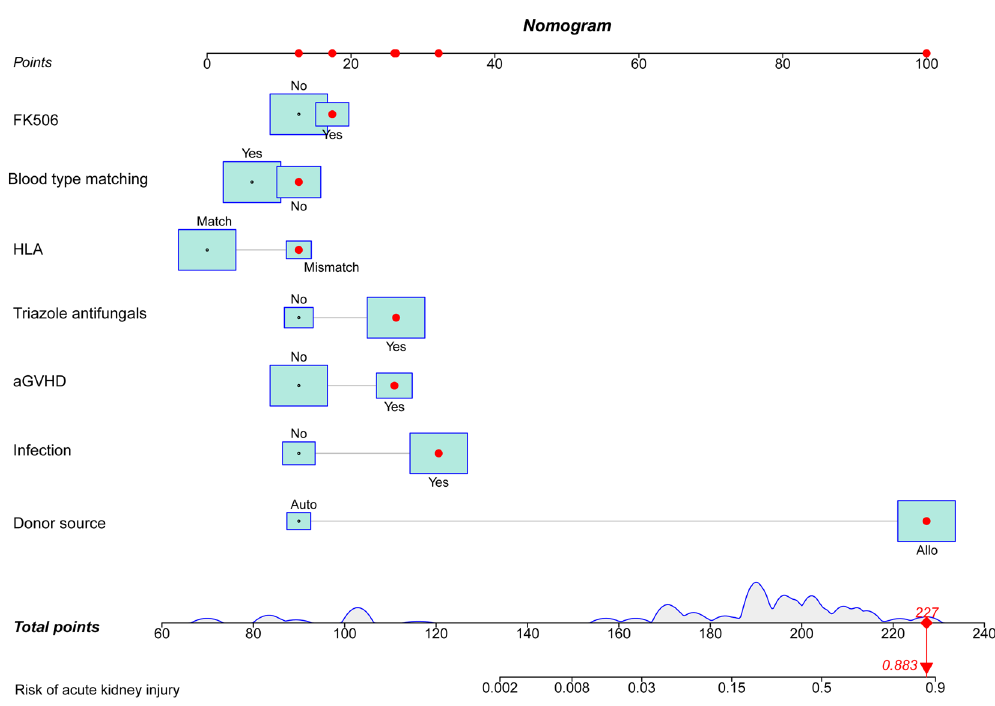
Figure 3. The nomogram was constructed to predict the risk of